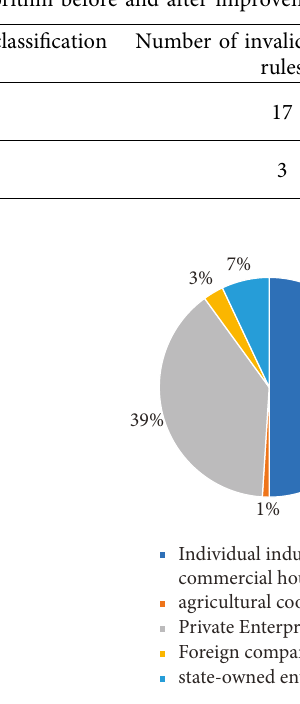
Figure 4: Statistical chart of business administration data: com- position and distribution of market players.